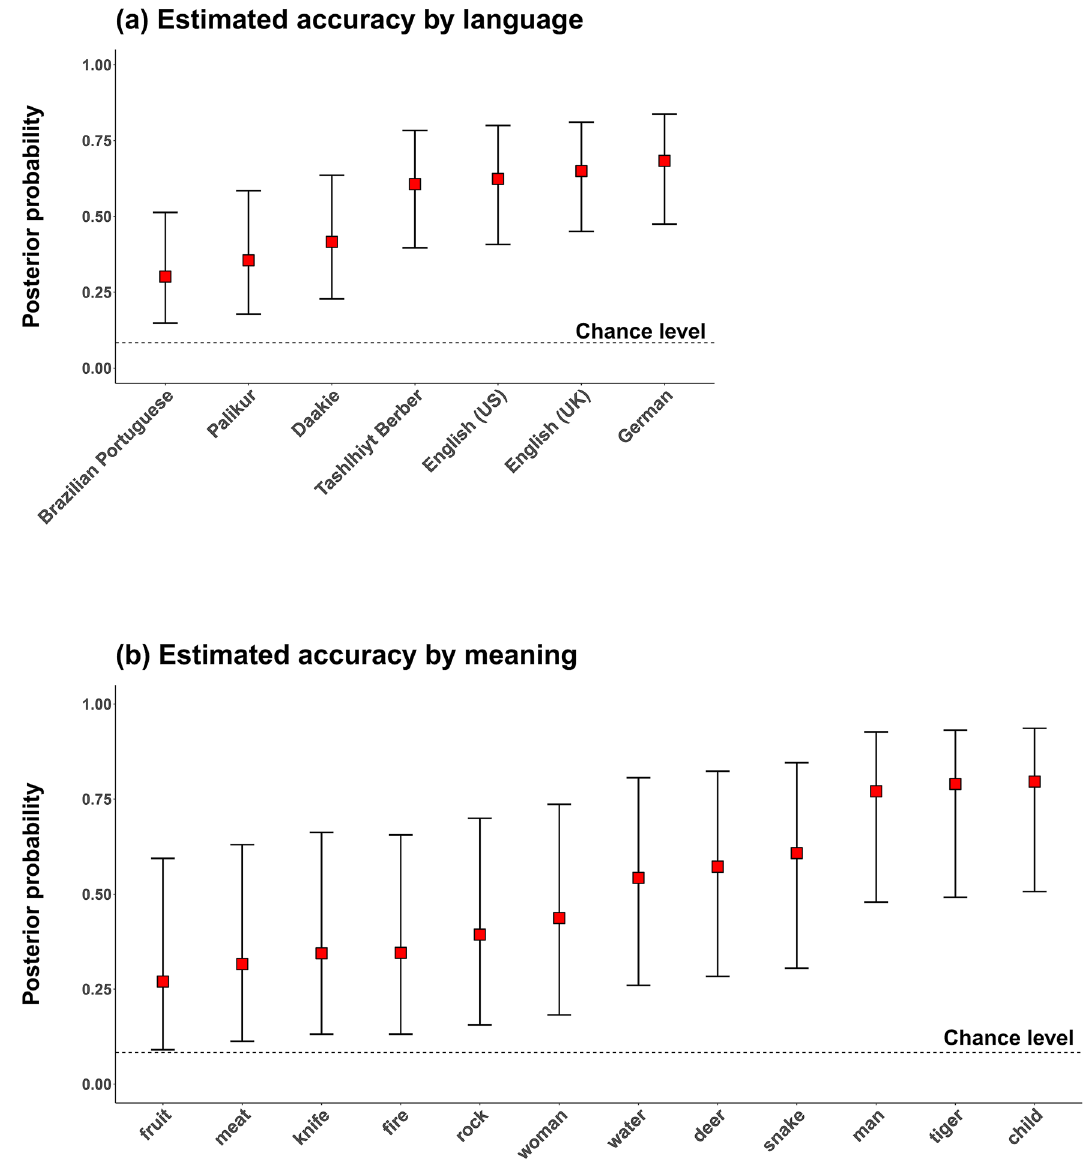
Figure 3. Posterior probability of a correct guess in the field experiment ( a ) per language and ( b ) concept; the red squares indicate the posterior means and error bars the 95% Bayesian credible intervals. The values displayed in this figure correspond to the model that takes into account random effect variation by meaning, vocalization, language, listener, and creator of vocalization.